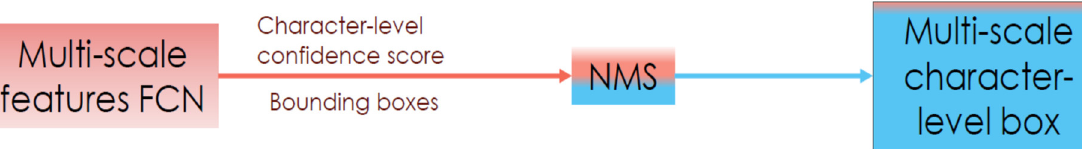
Figure 2. The much simpler proposed pipeline for detection the text in old documents that allows for one-stage training with no more steps that would cause wasting of time.